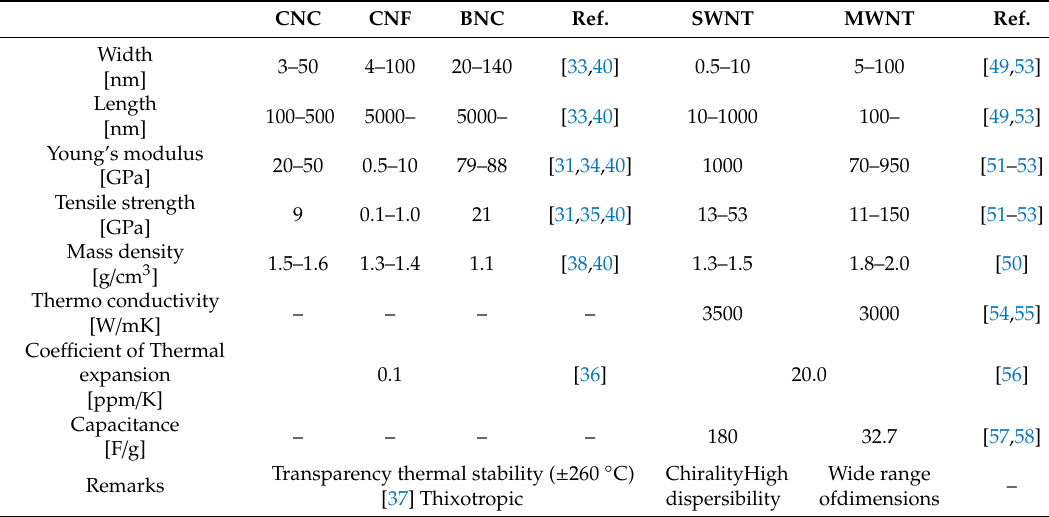
Table 2. Comparison of NC and